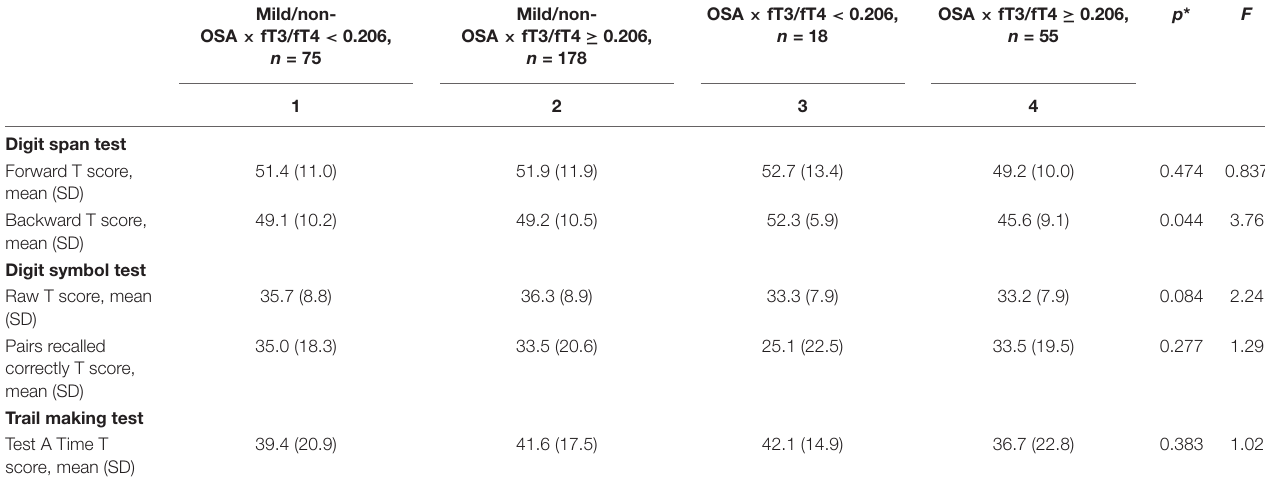
TABLE 4 | Means differences of the cognitive functioning in the four groups stratified according to the presence of obstructive sleep apnoea and the level of fT3/fT4 (high vs. low). Mild/non- Mild/non- OSA × fT3/fT4 < 0.206, OSA × fT3/fT4 ≥ n = 75